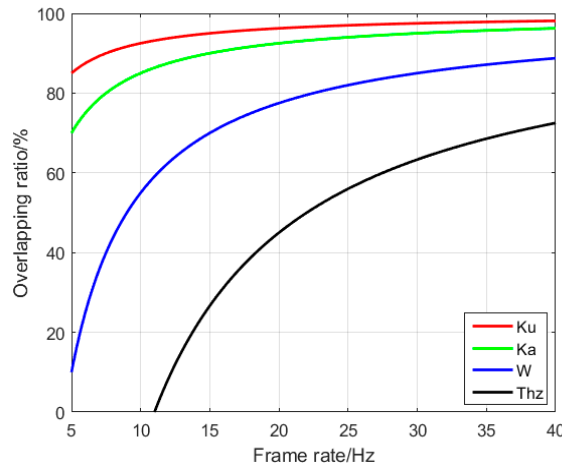
Figure 7. The relationship between overlapping ratio and frame rate.